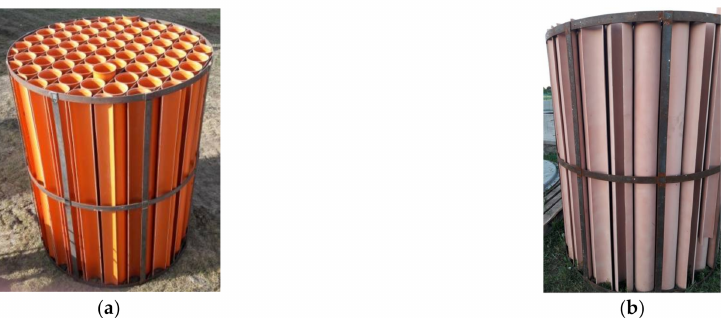
Figure 9. Filling the fermentor, skeleton bed made of vertical type pipes A PVC-U S4 UD placed in the basket-view: ( a ) no roughness on the surface of pipes; ( b ) roughness on the surface of pipes after sandblasting is 80 µ m (photo by Grzegorz